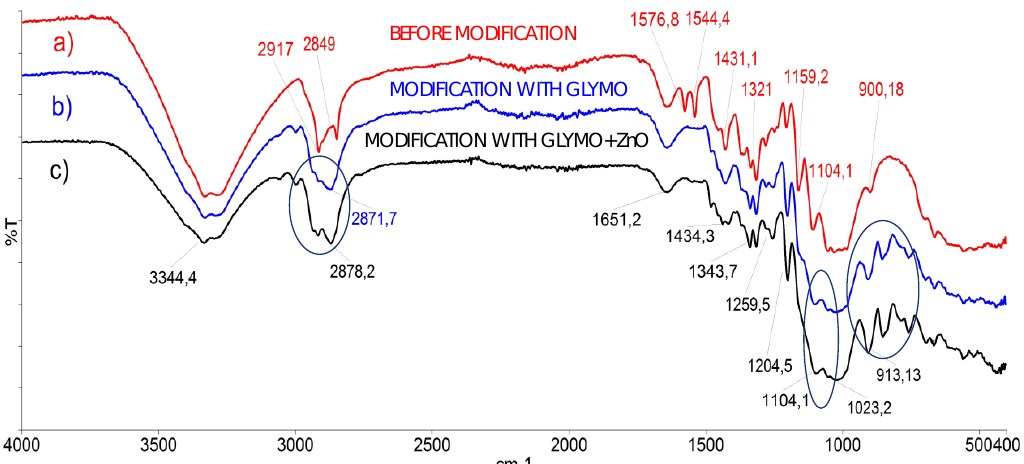
Figure 2. Fourier-transform infrared spectra of cellulose sample before and after the modification with the ZnO nanoparticles: ( a ) Red line: FTIR-Attenuated Total Reflectance (ATR) spectra of cellulose sample before modification, ( b ) Blue line: FTIR ATR spectra of cellulose sample after modification with 3-glycidyloxypropyltrimethoxysilane (GLYMO), ( c ) black line: FTIR ATR spectra of cellulose sample modified with ZnO nanoparticles and GLYMO, with optimal modification parameters calculated by the Design of Experiment program. Three blue circles define area of the epoxy groups were determined around ~905 and 911 cm −1 , the area around 1100 cm −1 is linked to Si–O groups, (particularly Si–O–C and Si–O–Si bridges), and the conversion of metoxy groups in precursor GLYMO are distinguished at ~2870 cm −1